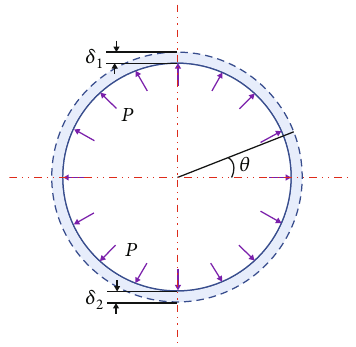
Figure 4: Schematic diagram of excavation hole deformation under expansion